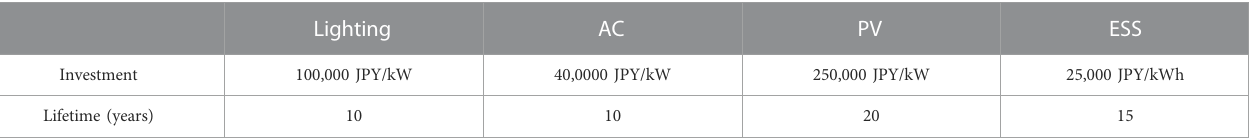
TABLE 5 Equipment price and lifetime.